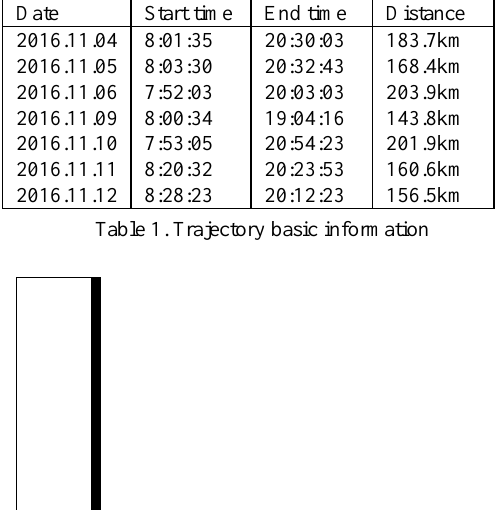
Figure 2. Data processing flow